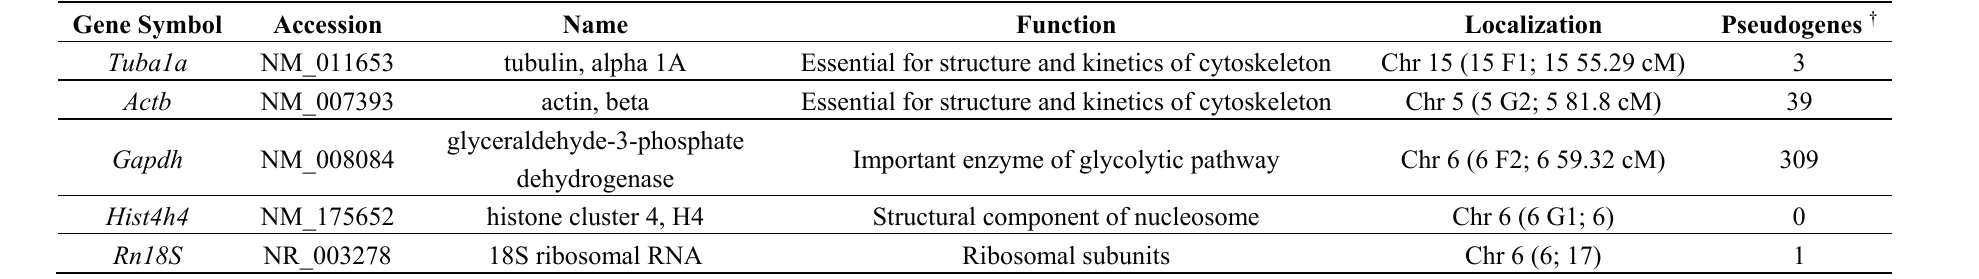
Table 1. Internal control genes evaluated in this study.